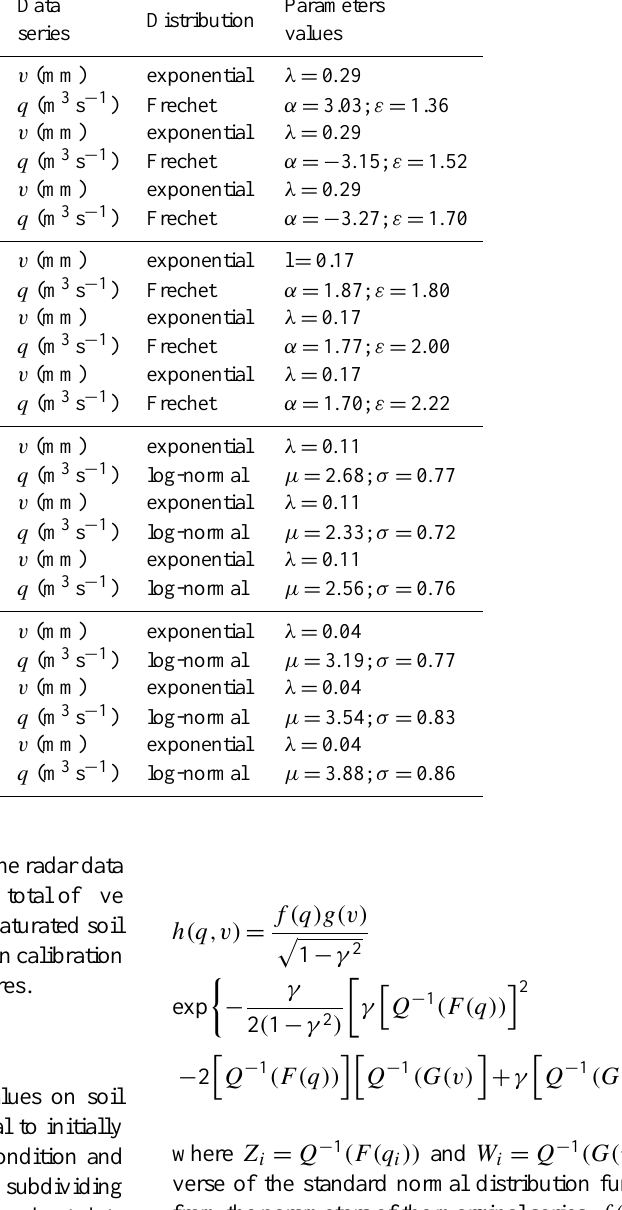
Table 2. Marginal distributions parameters of observed cumulated values v and corresponding peak discharge q , sorted by duration. AMC Data Duration